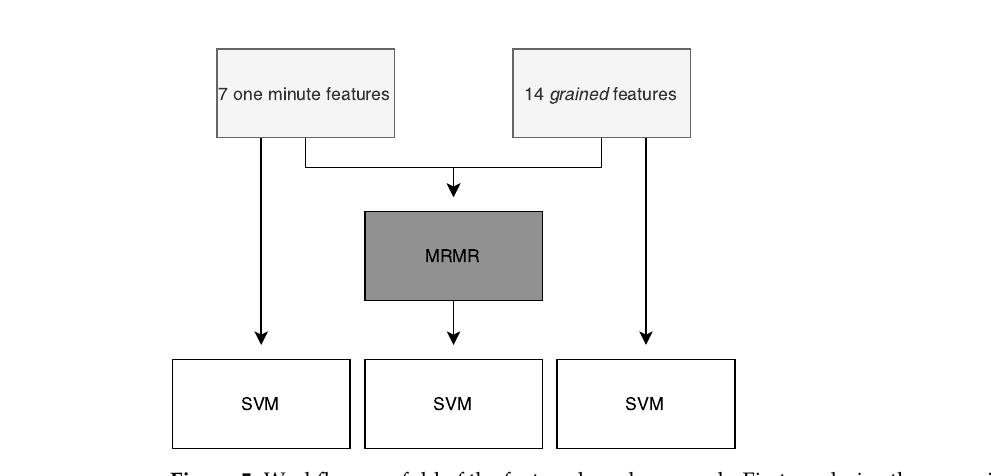
Figure 5. Workflow per fold of the feature-based approach. First we derive the one-minute and grained features. These are used to train separate SVM models. Then, we use the minimum redundancy, maximum relevance (MRMR) algorithm to rank all features and retrain the SVM model with the highest ranked